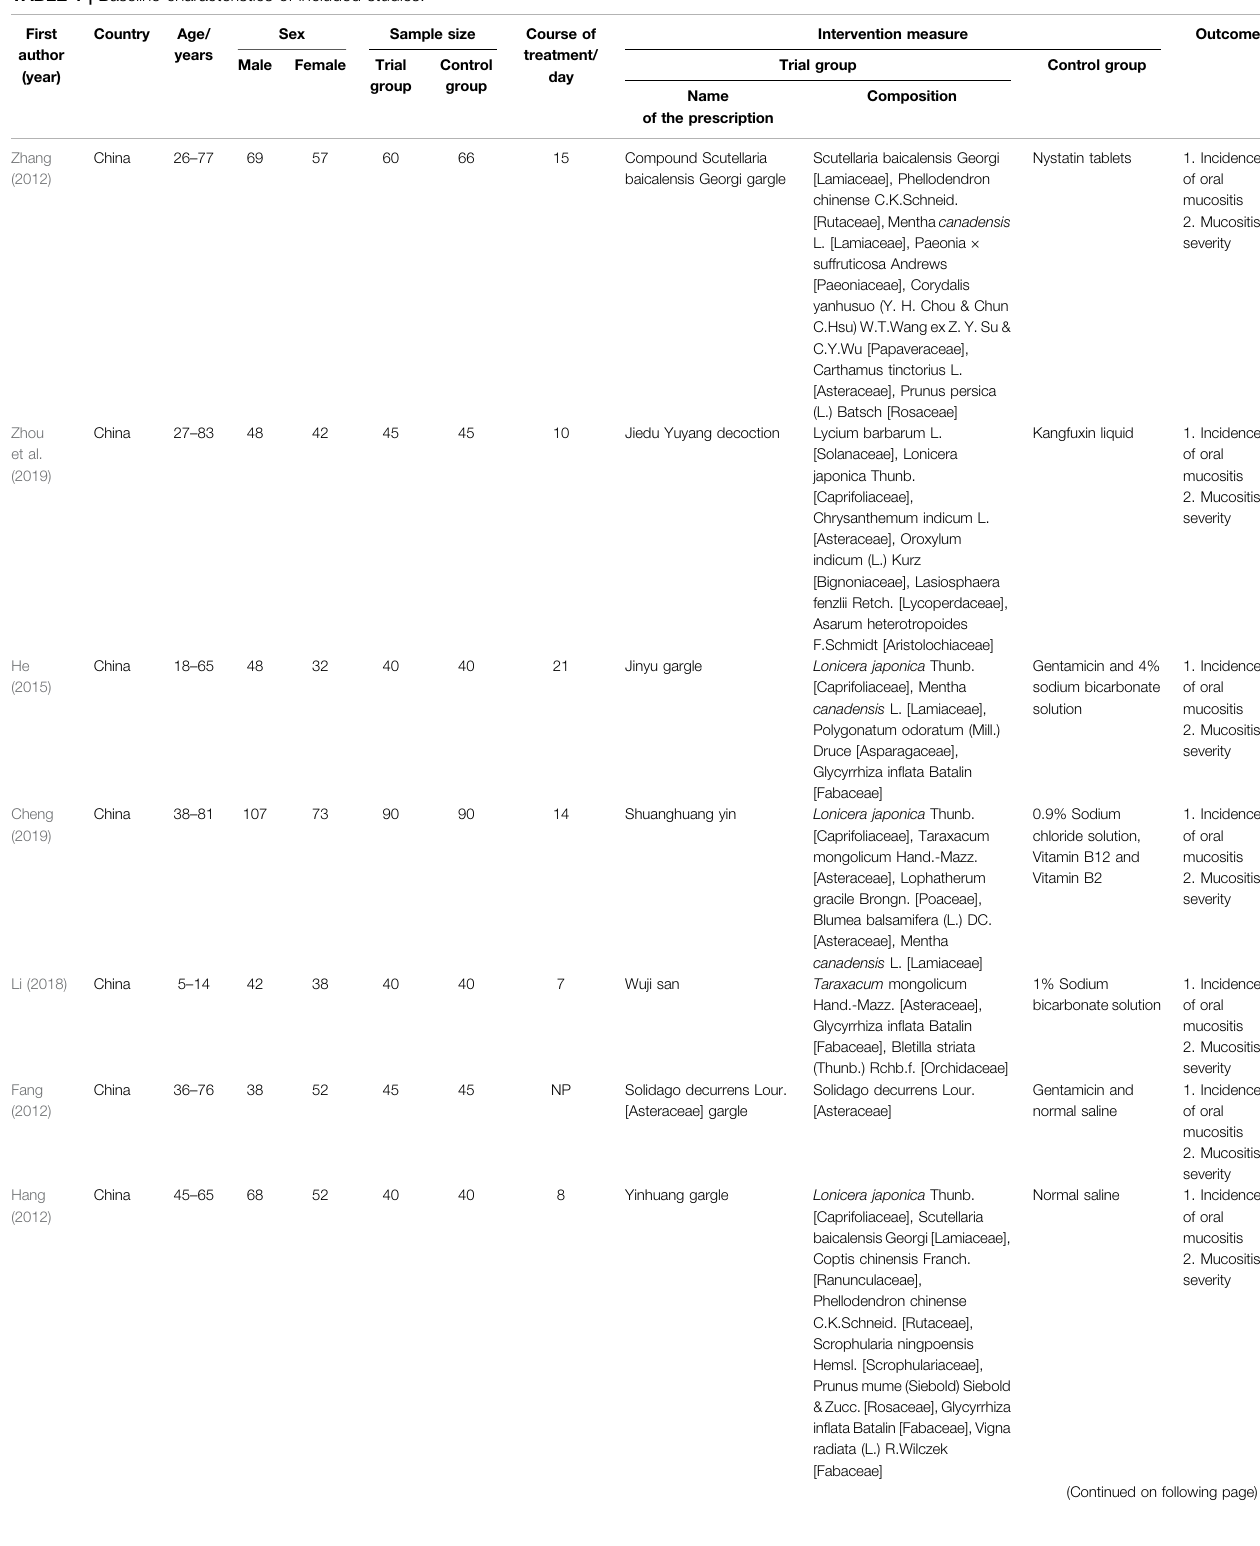
TABLE 1 | Baseline characteristics of included